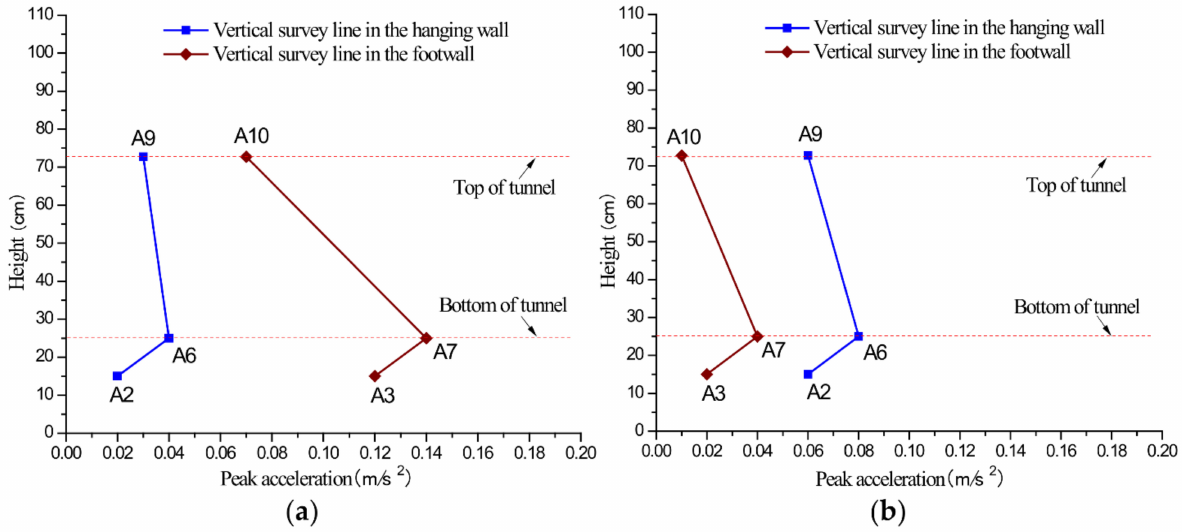
Figure 11. Peak acceleration curves under the scenario of hanging wall descend 1 cm: ( a ) vibration exciter at 60 cm; ( b ) vibration exciter at 100